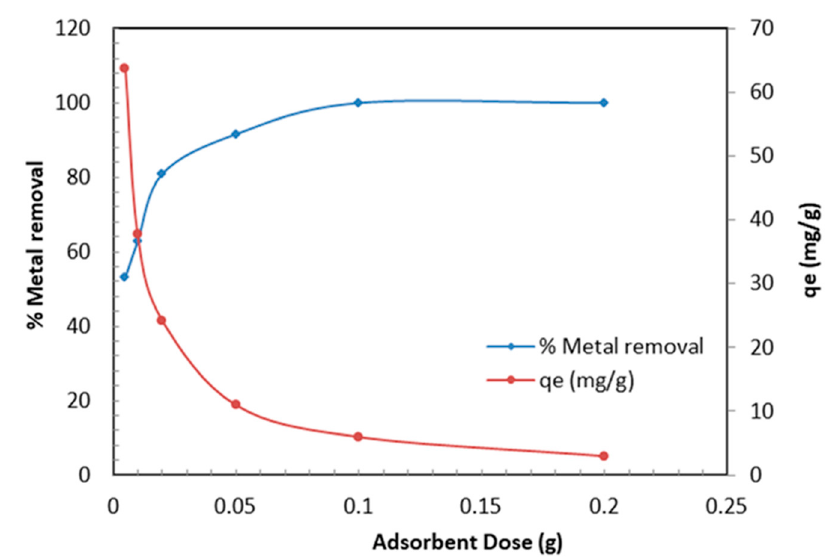
Figure 7. Effect of TBC-P dose on metal removal efficiency and adsorption